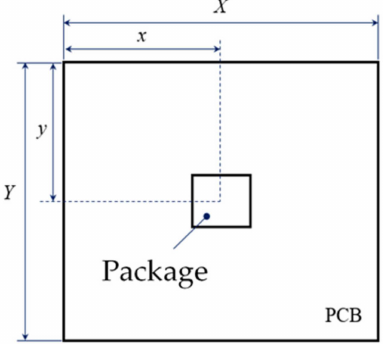
Figure 11. Location factor of component related to relative position factor of